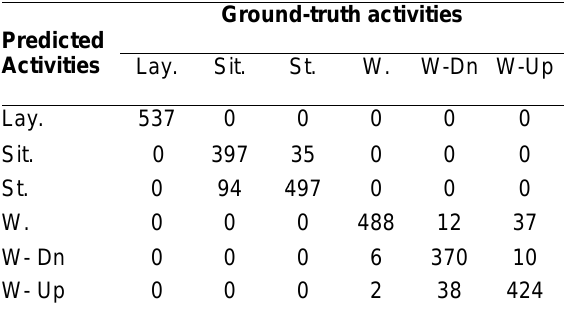
TABLE 5 : Comparative results: Sequential vs Parallel